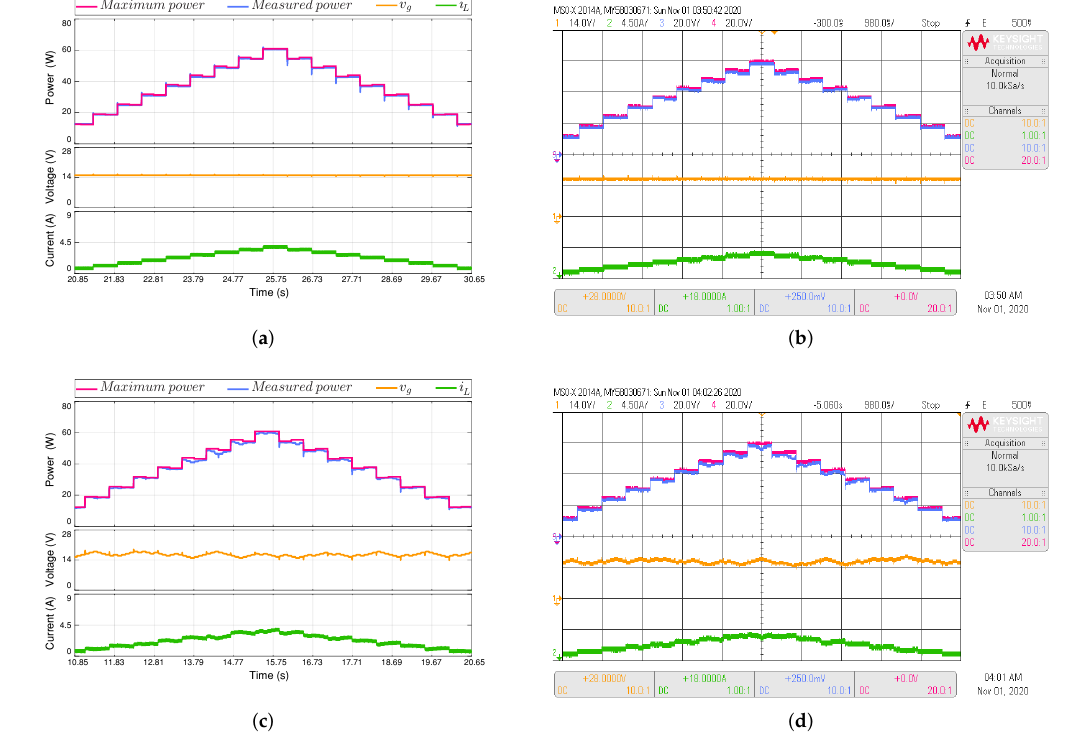
Figure 11. Simulated ( a , c ) and experimental ( b , d ) dynamic behavior of the MPPT algorithms dealing with changes in irradiance and temperature according to the profile shown in (FALTA). Output voltage V o = 36 V. The proposed MPPT algorithm (top) is compared with perturb and observe (P&O)-based MPPT algorithm (bottom). CH1: v g (14 V/div), CH2: i L (4.5 A/div), CH3: Maximum power (20 W/div), CH4: Measured power (20 W/div) and a time base of 980